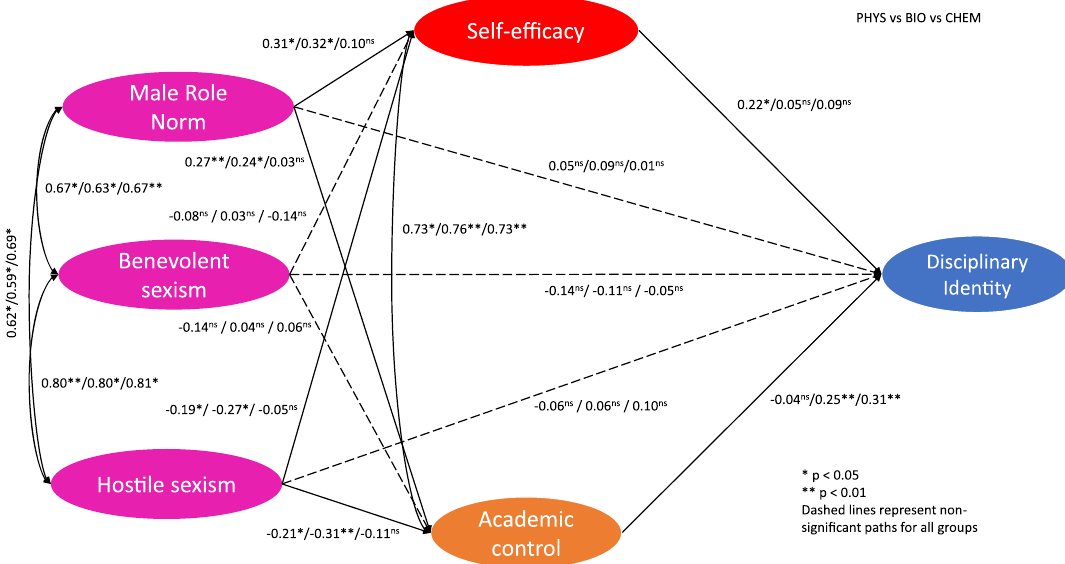
FIG. 4. Path analysis showing the relationships between gender stereotypes, self-efficacy, perceived academic control, and disciplinary identity for students attending extracurricular activities in physics, biology, and chemistry. Results are reported in the format: physics/